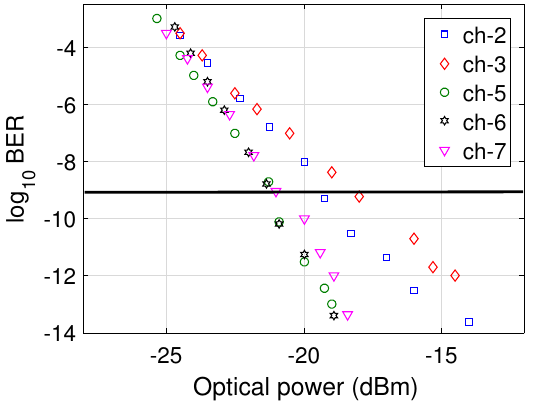
Figure 7. BER versus detected optical power plots of different